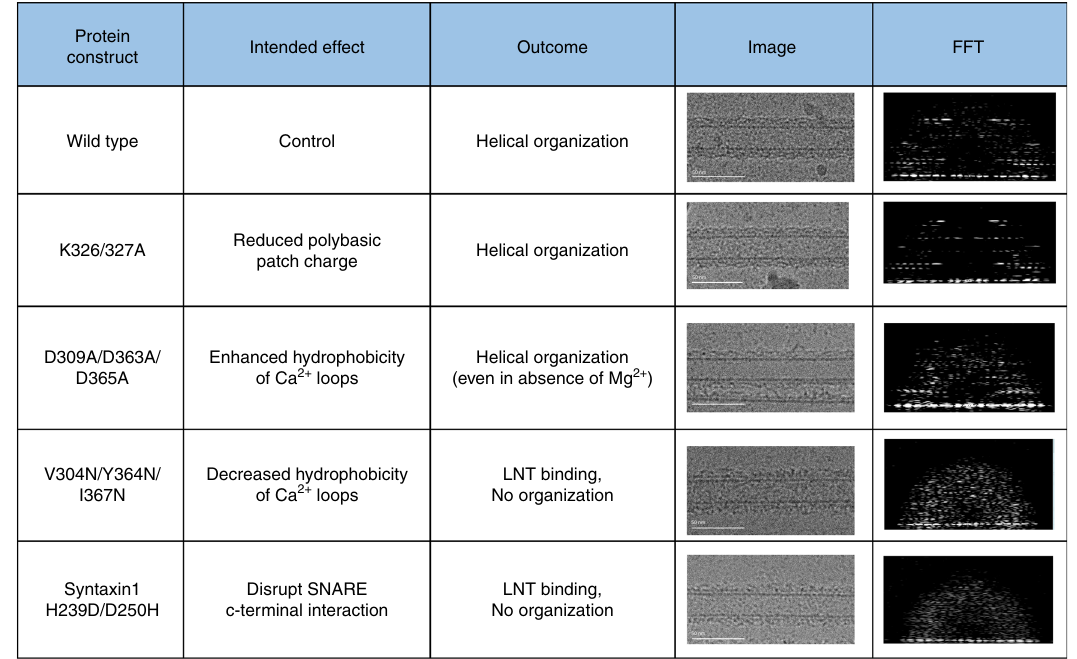
Fig. 3 Mutations in the Syt1 C2AB and SNARE complex used to identify and validate critical crystallographic contacts. The mutations were assessed for their ability to form a helical crystal on the membrane surface by visual appearance and by helical diffraction pattern of corresponding Fourier transforms (shown as acquired at the vertical tubes orientation) of the decorated LNTs by Cryo-EM analysis. Disruption of the C2B polybasic patch (K326A/K327A) had no effect on helical organization, but alteration of the Ca 2 + -loops showed a strong effect highlighting its critical role. Disrupting the C-terminal interaction of the SNAREpin also interfered with the helical organization indicating its role in stabilizing the helical